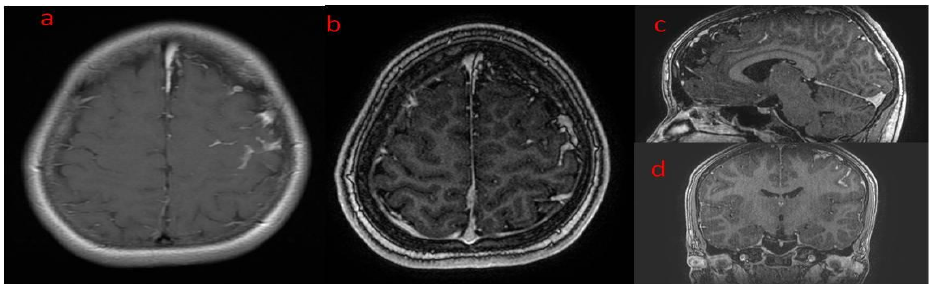
Figure 6. ( a – d ) Patient 2. Brain MR, T1 sequence after contrast enhancement: ( a ) axial; ( b ) thin-slice axial; ( c , d ) T1 multiplanar reconstructions: ( c ) sagittal and ( d ) coronal–meningeal enhancement along gyri of left hemisphere—frontal lobe.